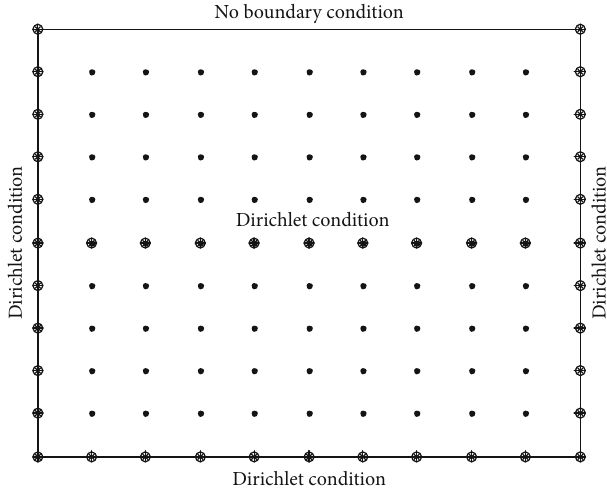
Figure 1: Domain for the fi rst stationary heat